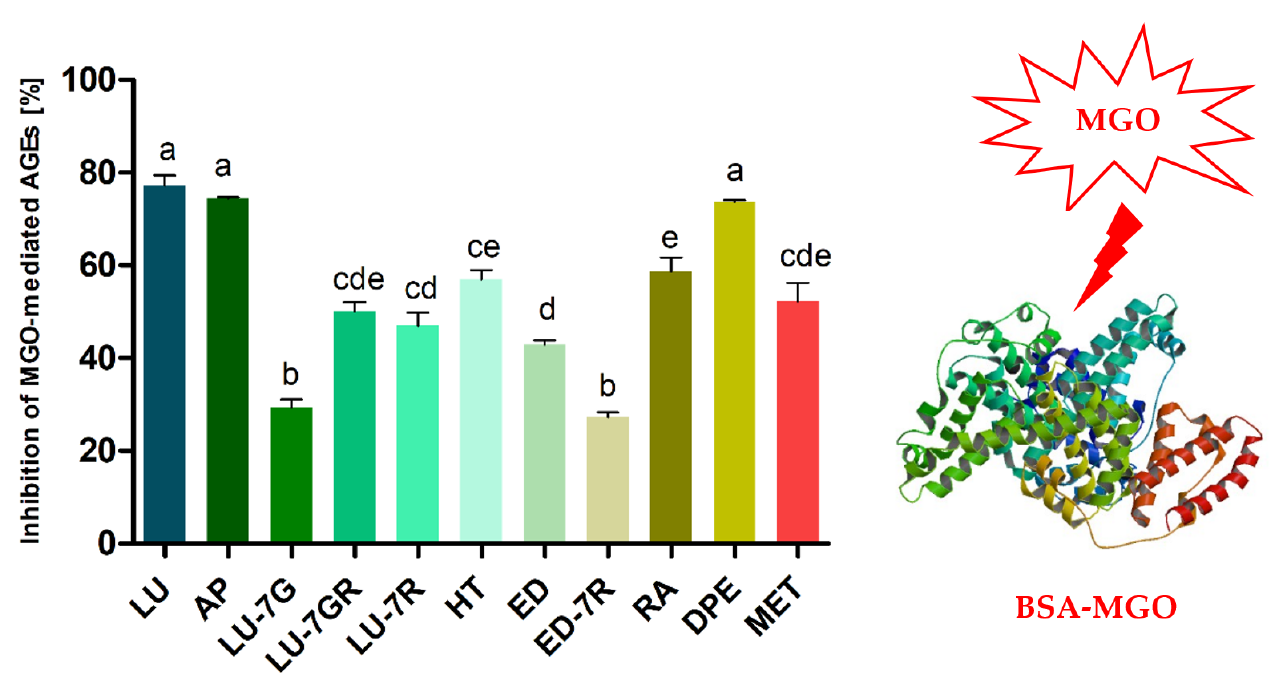
Figure 3. Antiglycation activity after seven-day incubation of bovine serum albumin with methyl- glyoxal (0.5 mM) and the test compound (1.5 mM) or peppermint leaf dry extract (3 mg/mL) expressed as % inhibition of MGO-induced AGE formation. Results are representative of three experiments performed as mean ± SD. Data were analyzed by one-way ANOVA ( p < 0.0001) followed by Tukey ’ s multiple comparisons test; values not sharing a common letter are significantly different.